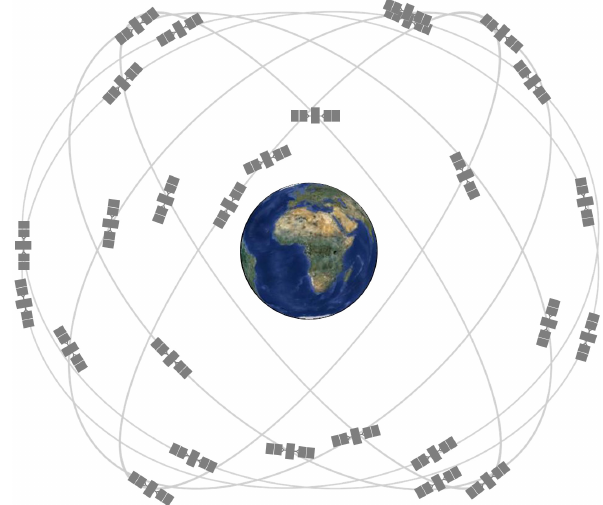
Figure 2. Natural localization model for satellites in the GNSS system (source: United States Government public domain, of- ficial US Government information about the Global Position- ing System (GPS) and related topics, 2014, http://www.gps.gov/ multimedia/images/, last access: October